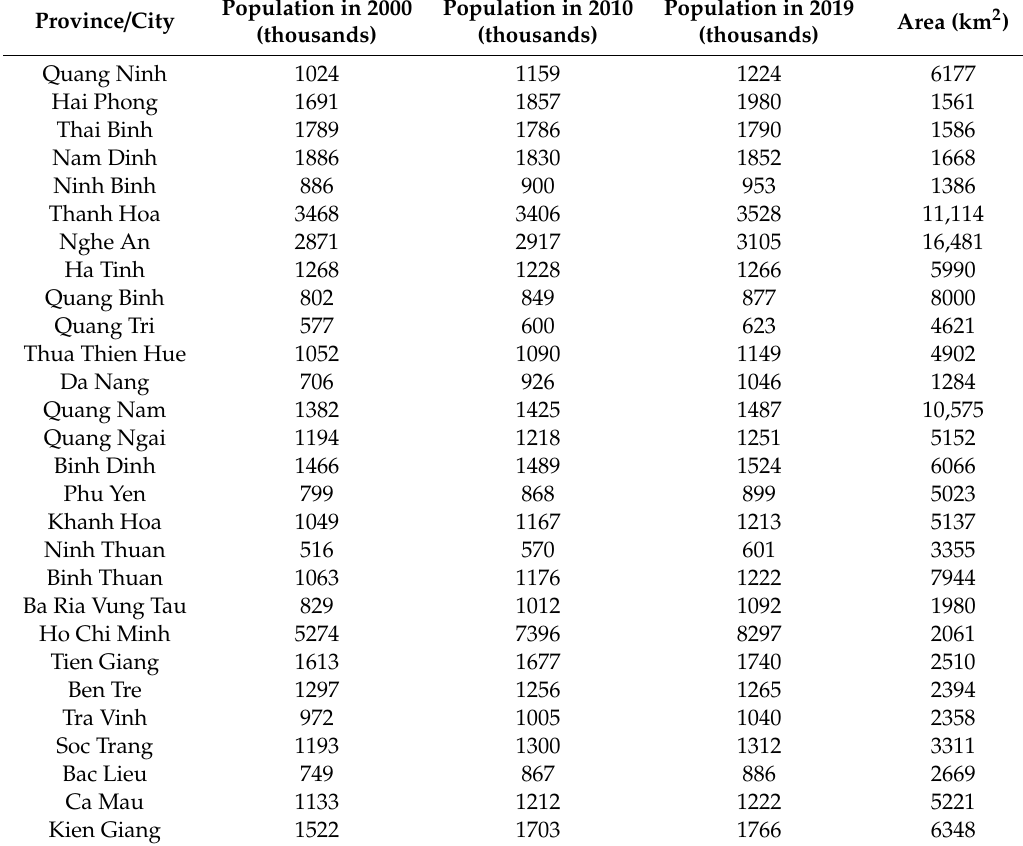
Table 2. Population of the Vietnam shoreline according to 2019 data